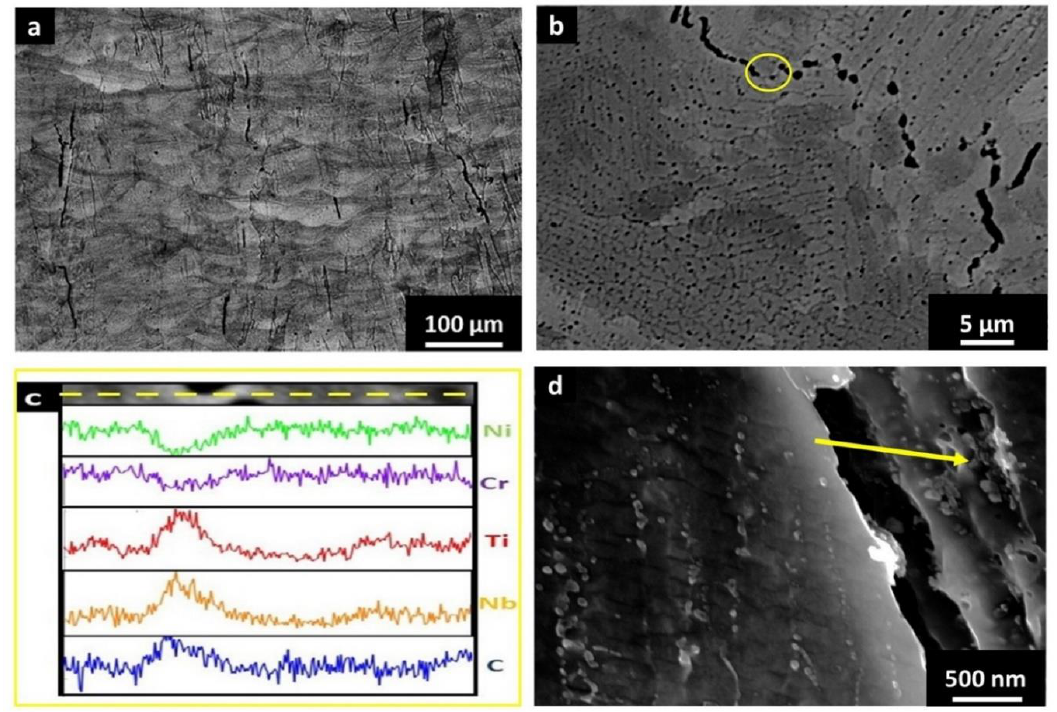
Figure 11. ( a ) LOM image of the LPBFed IN939 sample (S19) showing cracks mainly located along the grain boundaries; ( b ) SEM image of a crack along the grain boundaries; ( c ) EDS scan line performed across one of the typical “bridges” of a crack; ( d ) SEM image of the phases covering an intergranular crack. Kalling’s No.2 etchant was used.